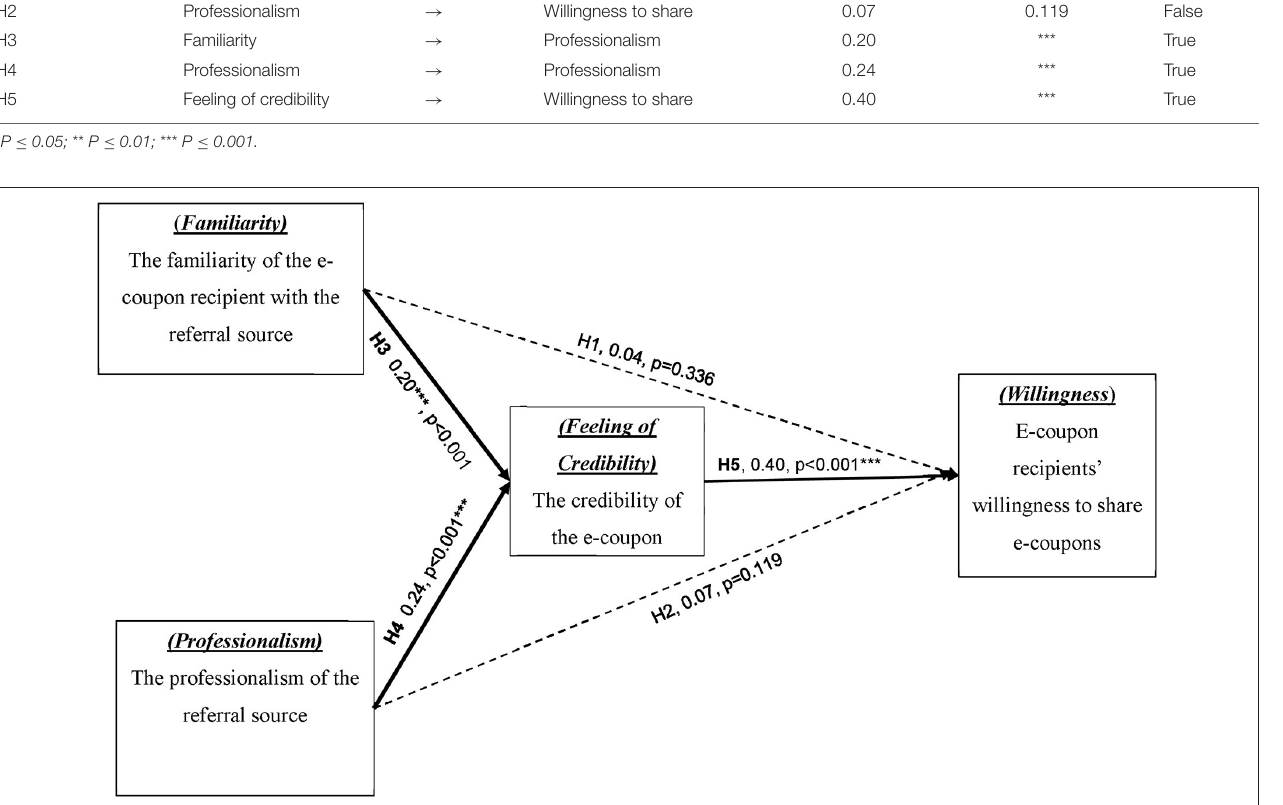
FIGURE 2 | Hypotheses testing results of the research framework of this